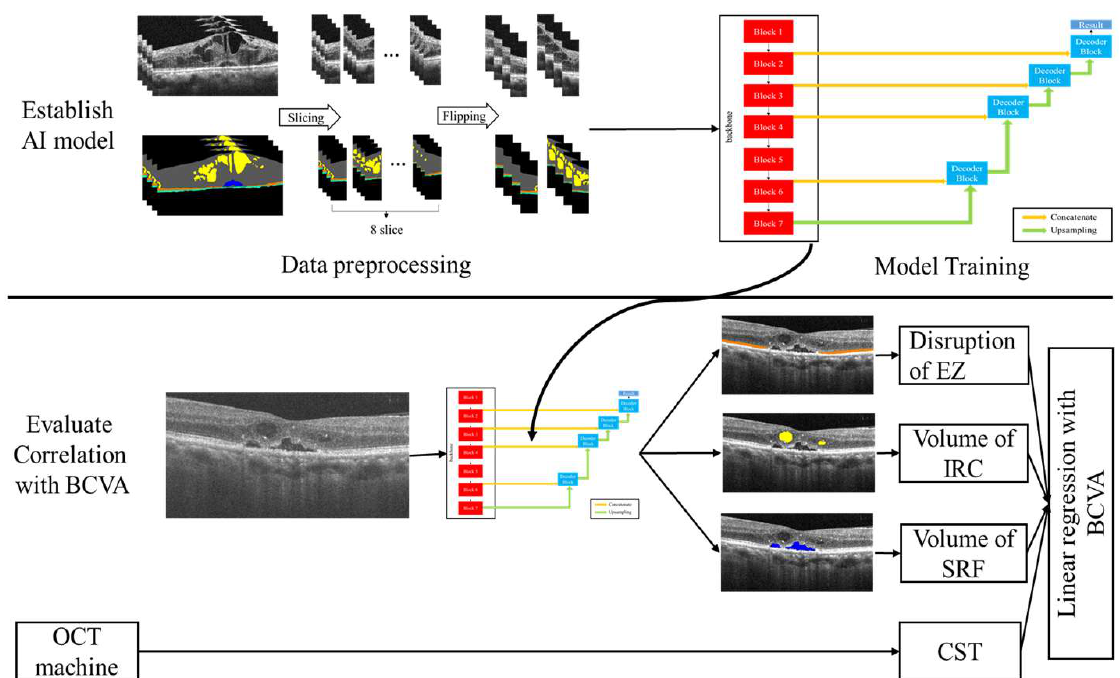
Figure 1. The overview of the experiment. AI: artificial intelligence; BCVA: best corrected visual acuity; EZ: ellipsoid zone; IRC: intraretinal cystoid fluid; SRF: subretinal fluid; CST: central sub- field thickness.